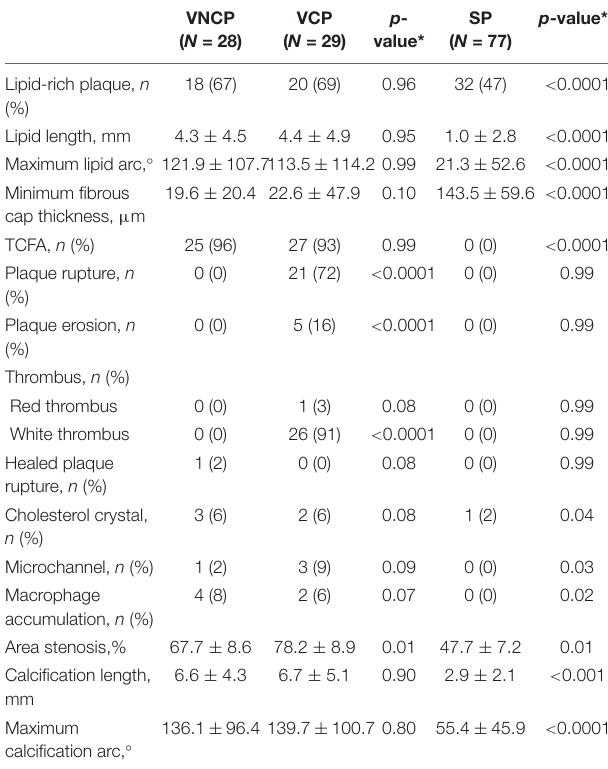
*Comparison between calcified stable plaques and calcified vulnerable plaques. **Comparison between calcified stable plaques and vulnerable plaques without culprit lesion. The values are means ± the SD or n (%). SD, standard deviation; SP, stable plaque; TCFA, thin-cap fibroatheroma; VCP, vulnerable culprit plaque; VNCP, vulnerable non-culprit